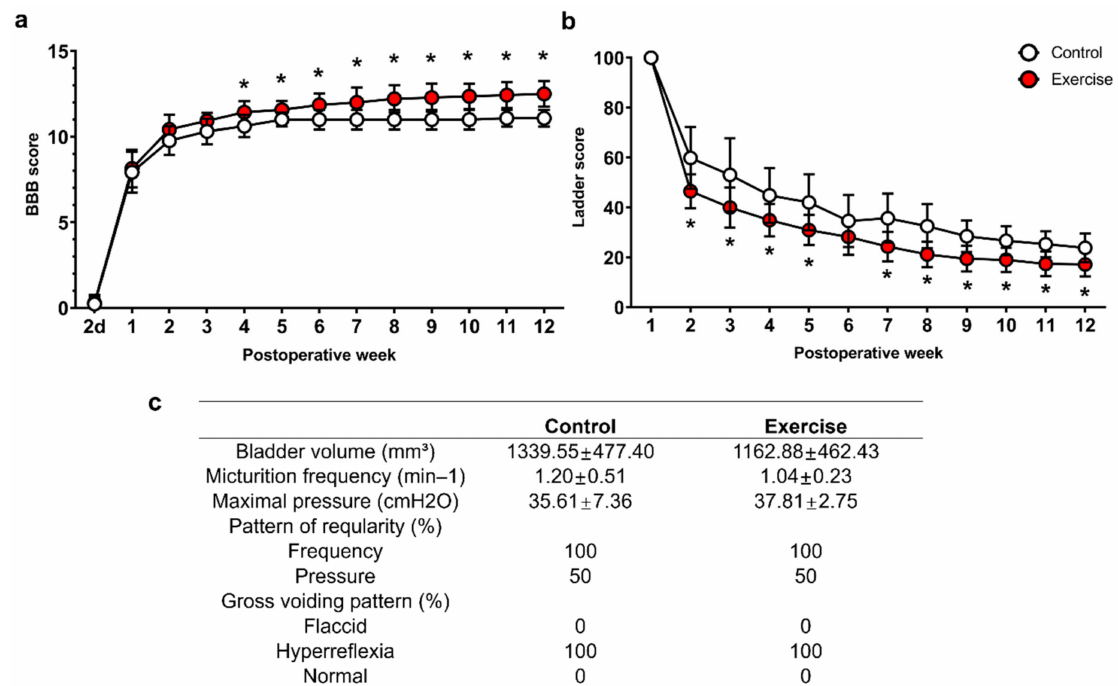
Figure 8. Functional recovery of spinal cord-contused rats in the control and exercise groups. The locomotor functions of rats with SCI were analyzed using ( a ) Basso, Beattie, and Bresnahan (BBB) scores and ( b ) horizontal ladder tests during the 12-week experimental period ( n = 13 for the control group, and n = 14 for the exercise group). ( c ) The results of the urodynamic study and measurement of bladder volume at 12 weeks after injury ( n = 6 per group). * p < 0.05 between the control and exercise groups by repeated-measures two-way ANOVA followed by Bonferroni test at each time